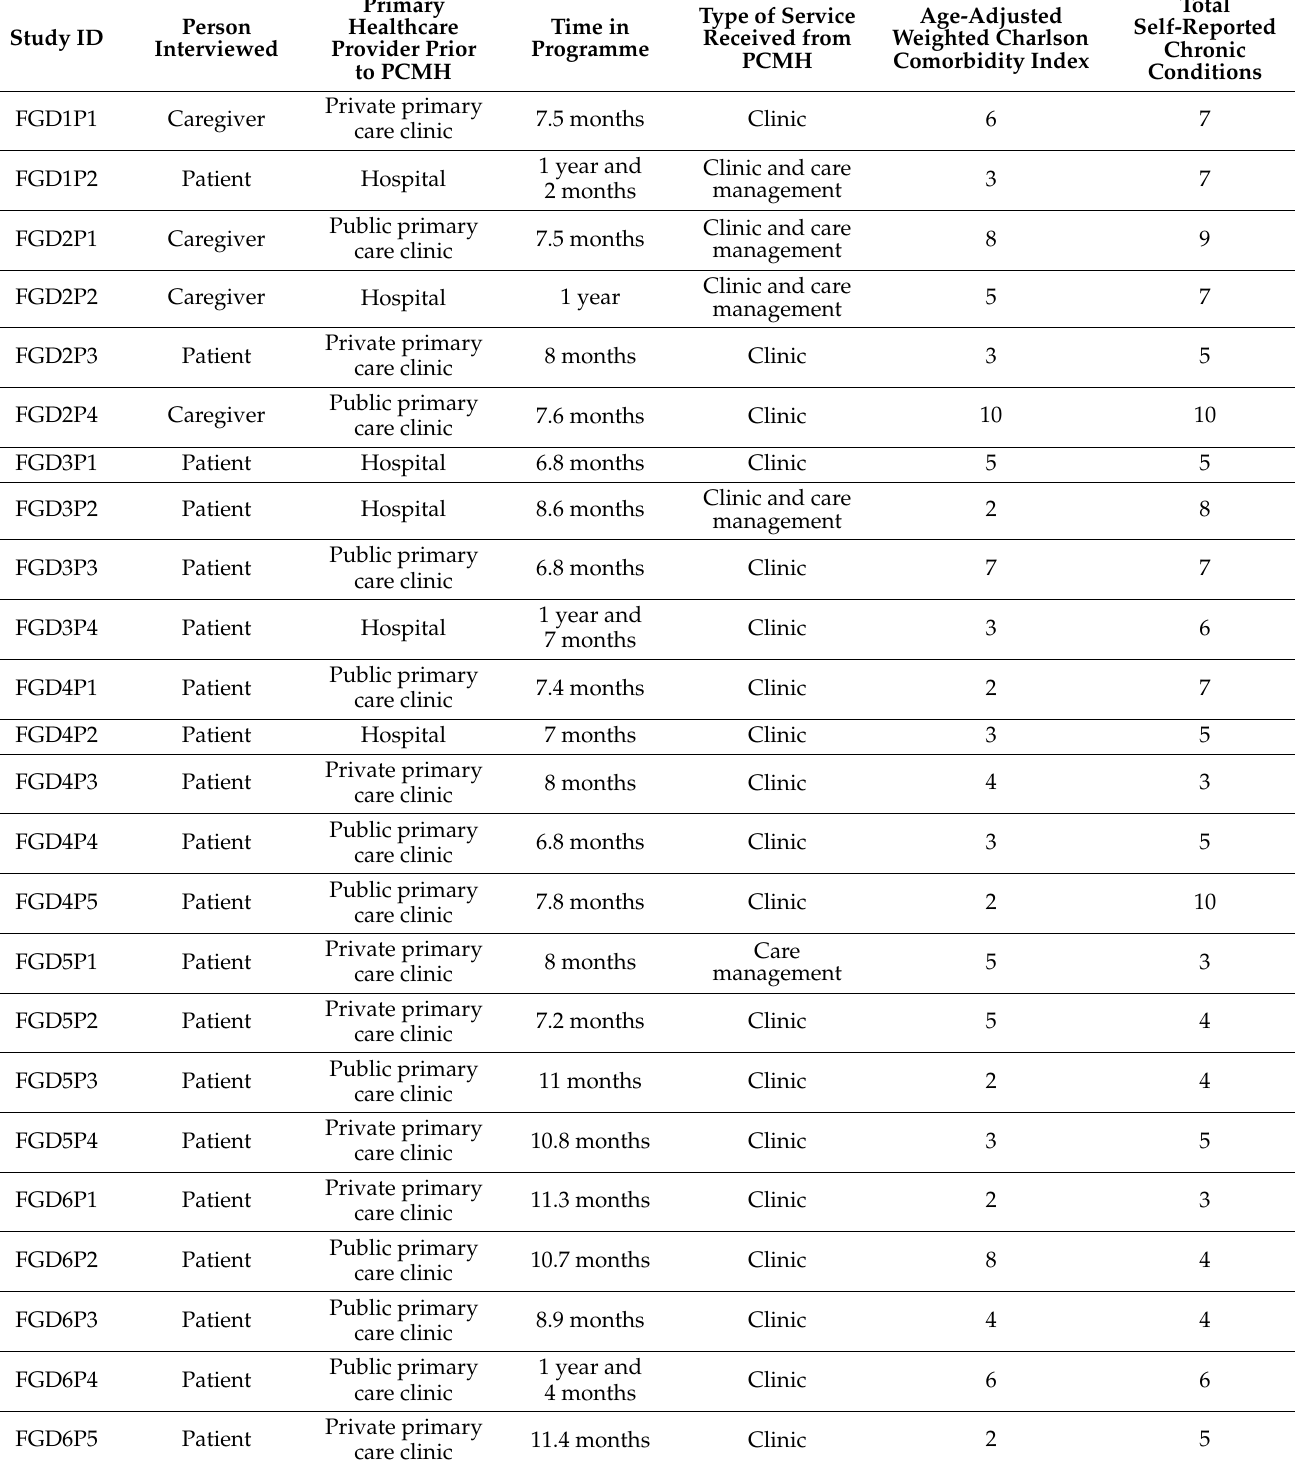
Table 2. Qualitative participants’